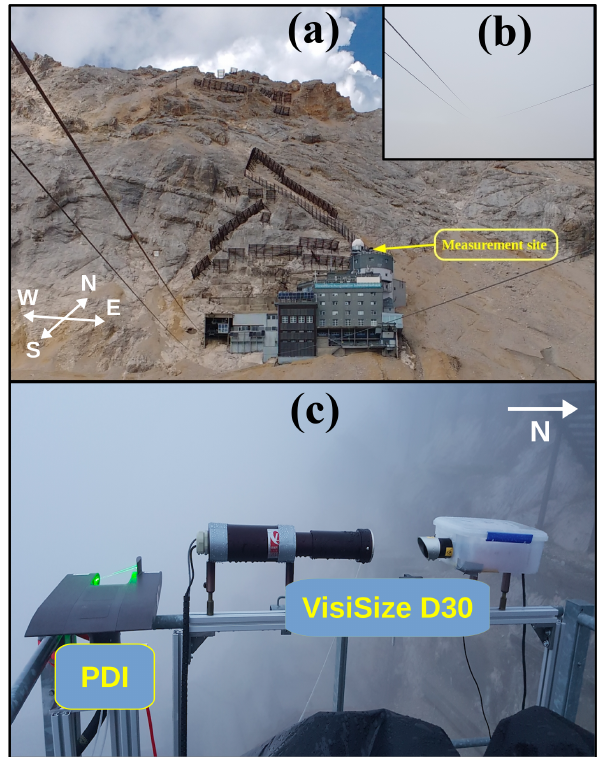
Figure 3. Cloud field experiment at the Schneefernerhaus: (a) view of the UFS from Zugspitzplatt on a sunny day, pointing out of the measurement site on the 9th floor platform; (b) the same view while the UFS is immersed in clouds; (c) main instruments: the VisiSize, and the PDI probe mounted next to each other measuring clouds which are approaching the UFS from the